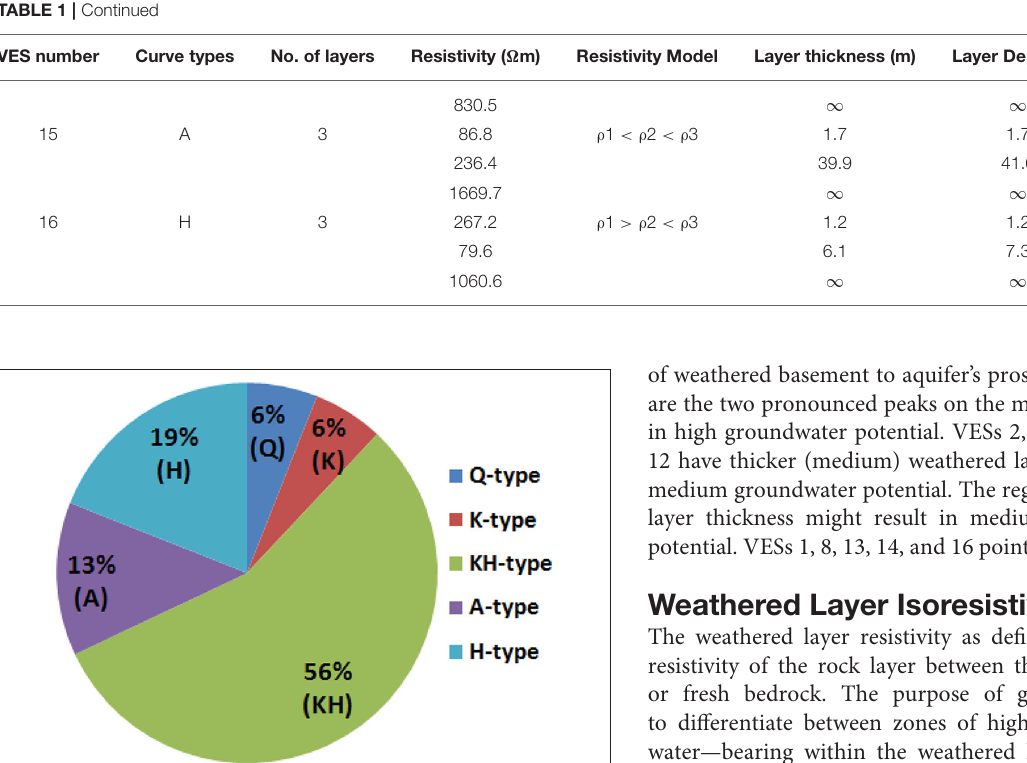
FIGURE 3 | Percentage Distribution of Curves in the study